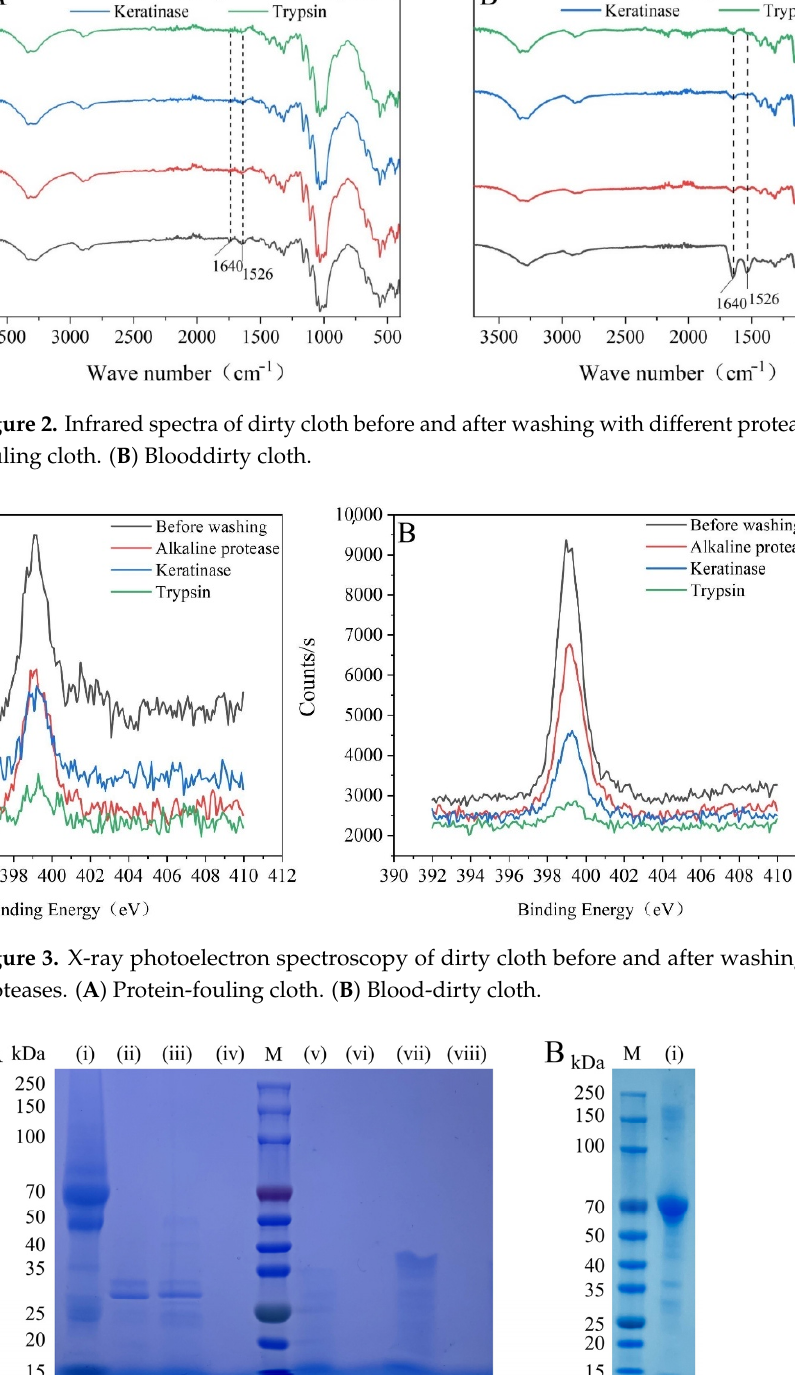
Figure 3. X-ray photoelectron spectroscopy of dirty cloth before and after washing with different proteases. ( A ) Protein-fouling cloth. ( B ) Blood-dirty cloth.